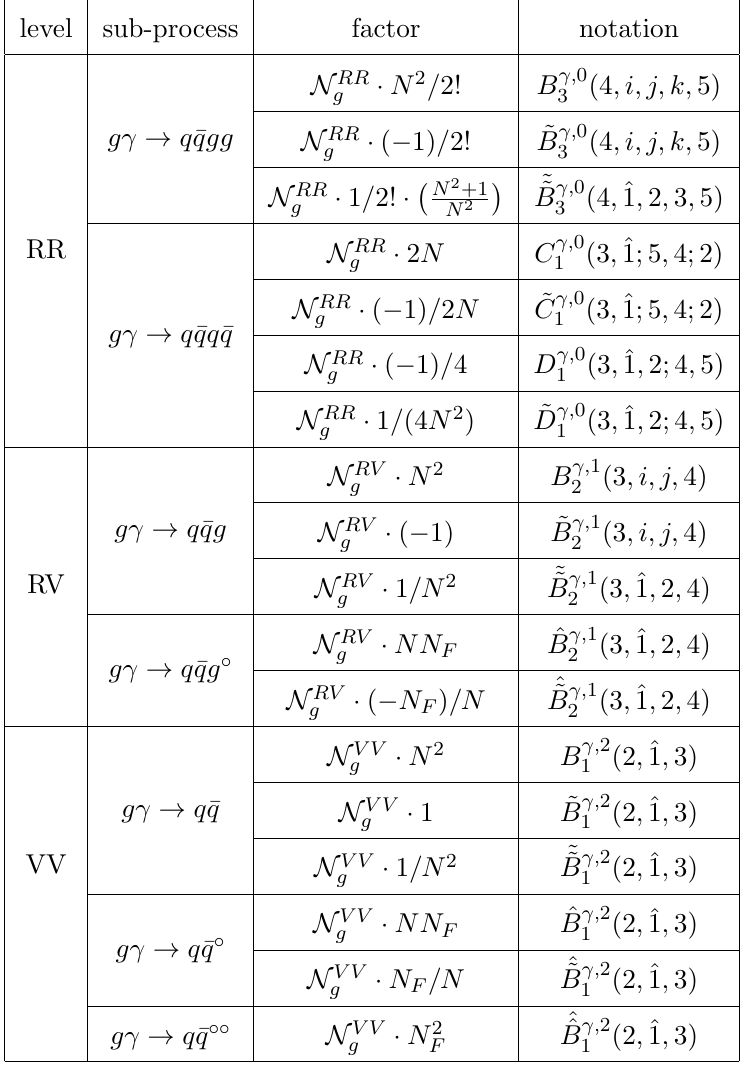
(4 ; i; j; k; 5) represents a sum over 3 (3 ; i; j; 4) represents a 2